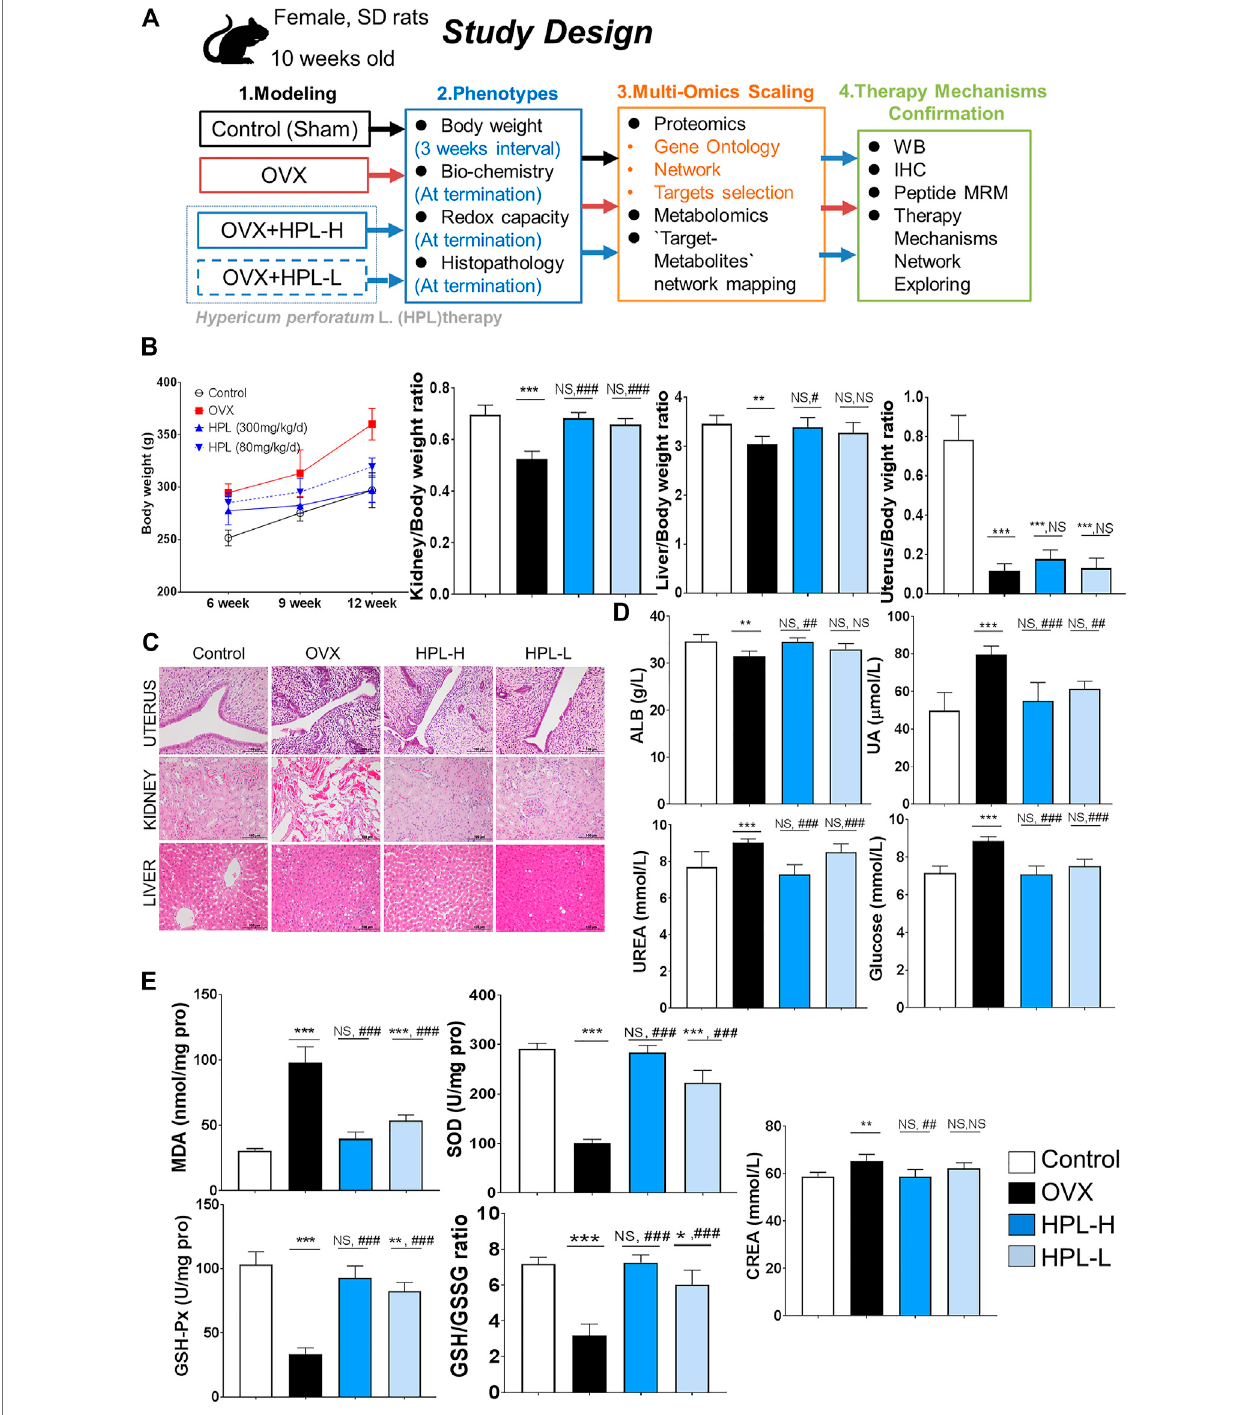
FIGURE 1 | HPL therapy ameliorated pathophysiological and biochemical phenotypes of kidney dysfunction and redox stress in rats with OVX. (A) Study design. (B) Average weekly body weight (g) from 0 to 12 weeks before and after surgery and average organ/body weight ratios of the kidney, liver, spleen, and brain ( n (cid:1) 6). (C) Histological images of uterine, kidney,and liver tissues. Scale bar (cid:1) 100 µm. (D) Renal biochemical pro fi les ofserum levels ofALB, UA, urea, GLU, and CREA ( n (cid:1) 6). (E) Redox pro fi les of MDA, SOD, and GSH-Px levels, and the GSH/GSSG ratio in serum samples ( n (cid:1) 6). The data are pooled from three experiments (means ± s .d.). HPL therapy dosage: HPL-H, 300 mg/kg/d; HPL-L, 80 mg/kg/d. * p < 0.05, ** p < 0.005, and *** p < 0.0005 compared with control rats; # p < 0.05, ## p < 0.005, and ### p < 0.0005 compared with OVX rats. NS, not signi fi cant.